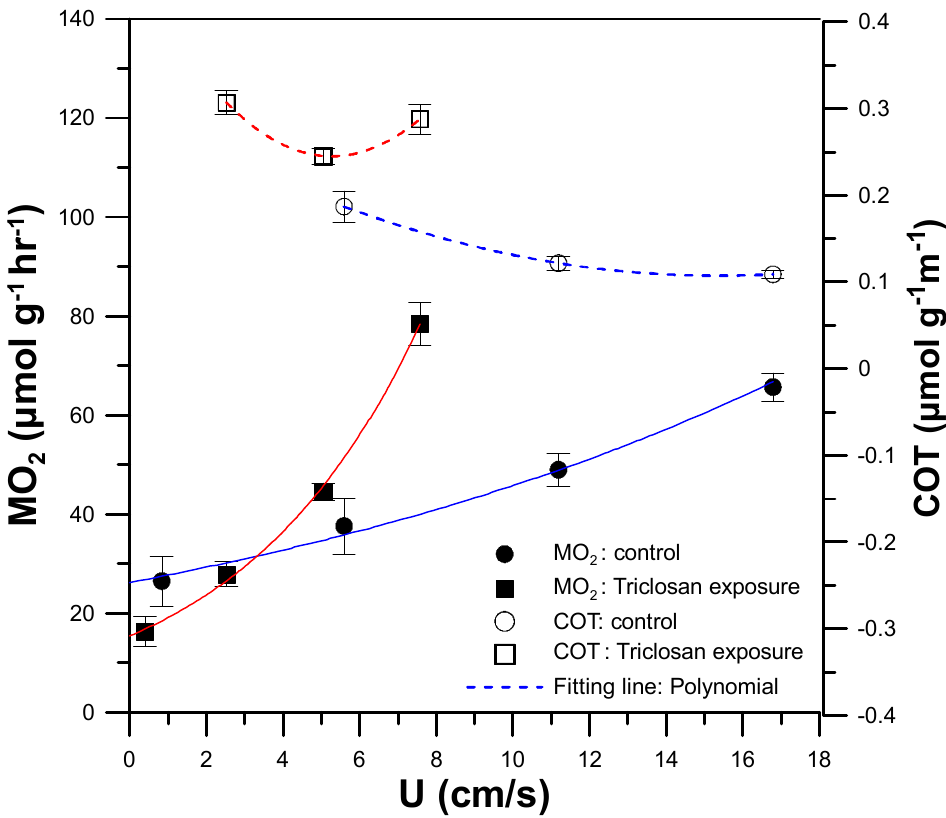
Figure 8. The metabolic rate (MO 2 ) (black squares and circles with solid lines) and COT (white squares and circles with broken lines) of a single 90 dpf zebrafish swimming at 5, 35, 70 and 100% U crit with or without (control group, normal zebrafish) exposure to 5 µ M Triclosan for 30 min. (Mean ± SEM; n =